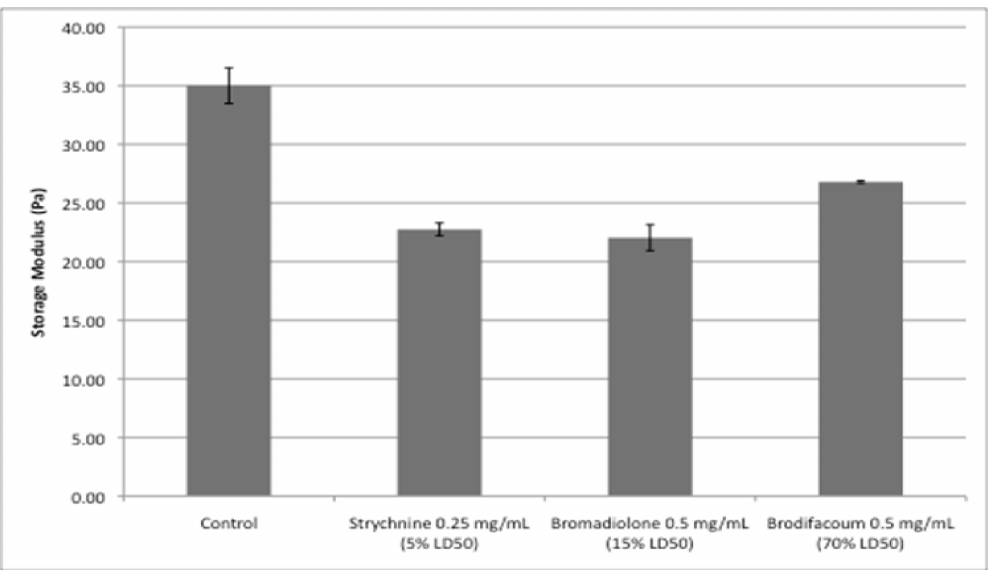
Figure 2. Impact of rodenticides on the coagulum strength of